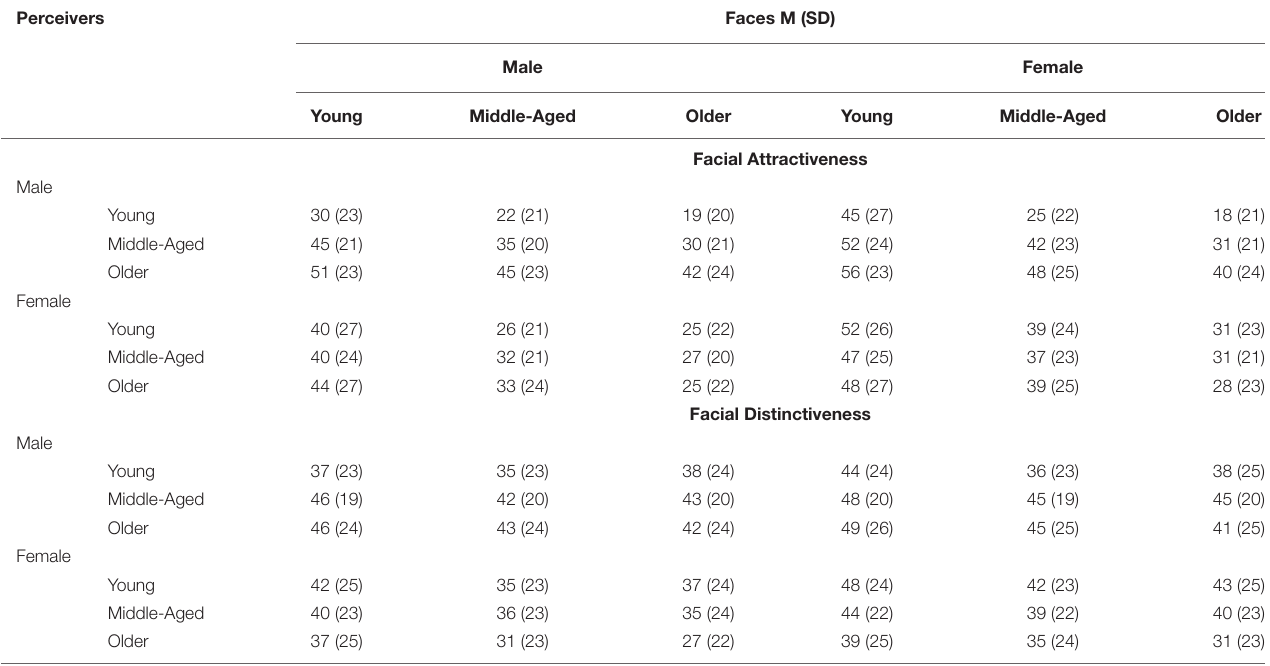
TABLE 1 | Raw means (and SDs) of facial attractiveness and distinctiveness ratings separately for age and gender of perceivers and faces. Perceivers Faces M (SD) Male Female Young Middle-Aged Older Young Middle-Aged Older Facial